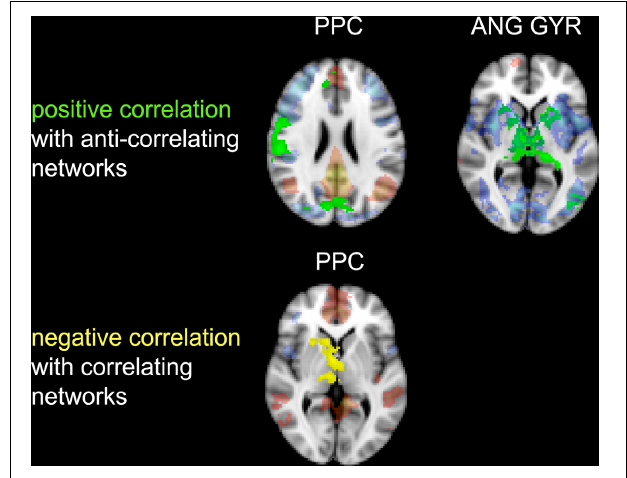
FIGURE 6 | Correlation between impulsivity and functional connectivity of the two seed clusters PCC and AG. ( Upper ) positive correlation (IM + ), drawn in green, with voxels belonging to the anti-correlating network (IC-GM − ). ( Lower ) negative correlation (IM − ), drawn in yellow, with voxels belonging to the correlating network (IC-GM + ). In semi-transparent mode are displayed the correlating (red) and anti-correlating (blue) voxel of IC-GM + and IC-GM −